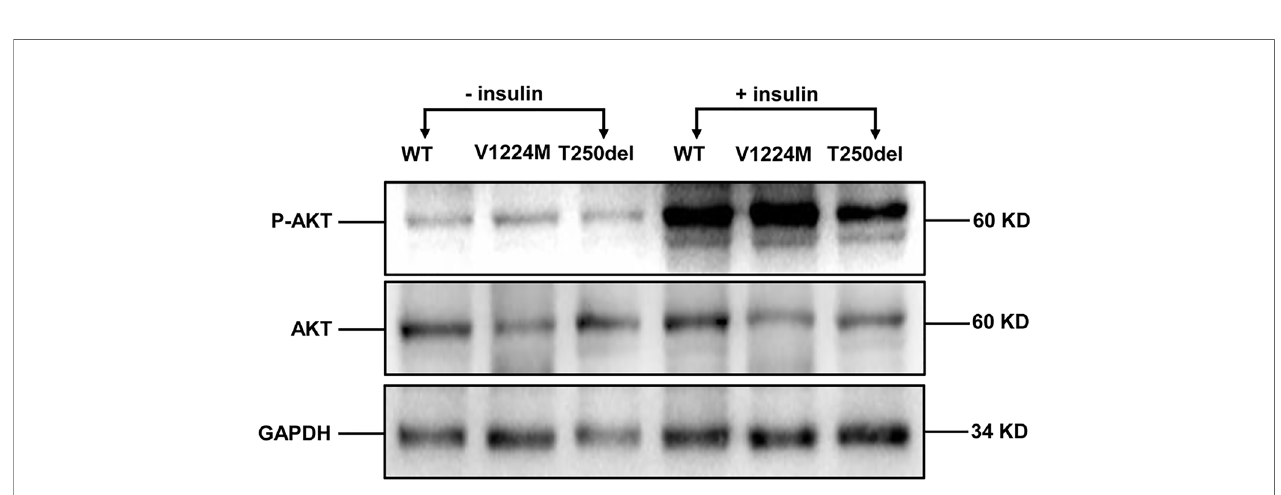
FIGURE 3 | Insulin-stimulated phosphorylation of Akt in CHO cells expressing WT and mutant INSRs. Western blot analysis of the total Akt (60 kD) and phospho- Akt (60 kD) with and without insulin